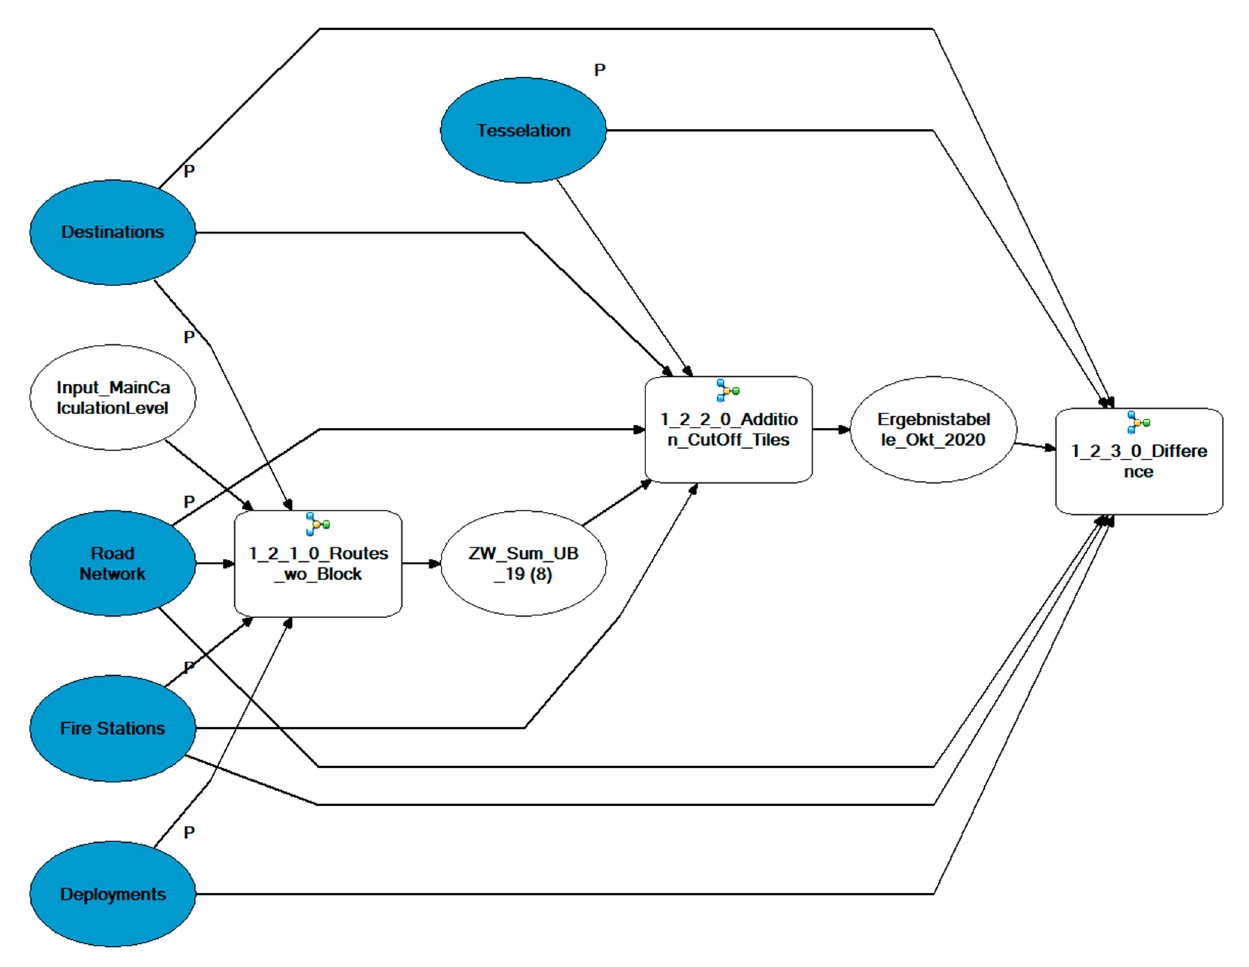
Figure A4. Final Calculation Level (CF_Endberechung) in ArcMap ModelBuilder.